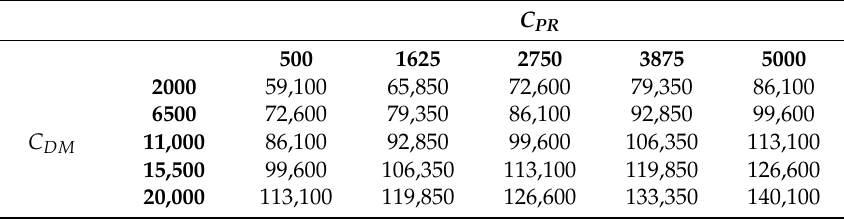
Table 3. Cost ( € ) analysis as a function of C DM and C PR —Setup #3.